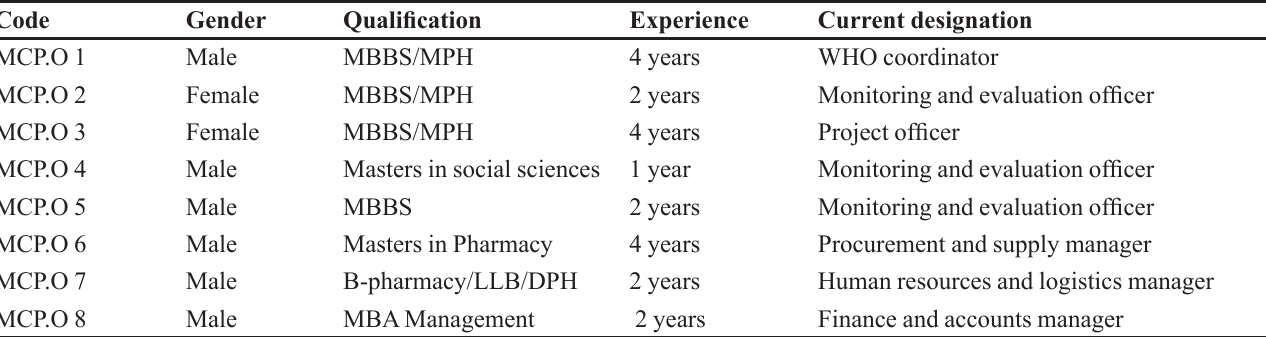
TABLE I - Demographic characteristics of officials working in the MCP, Pakistan